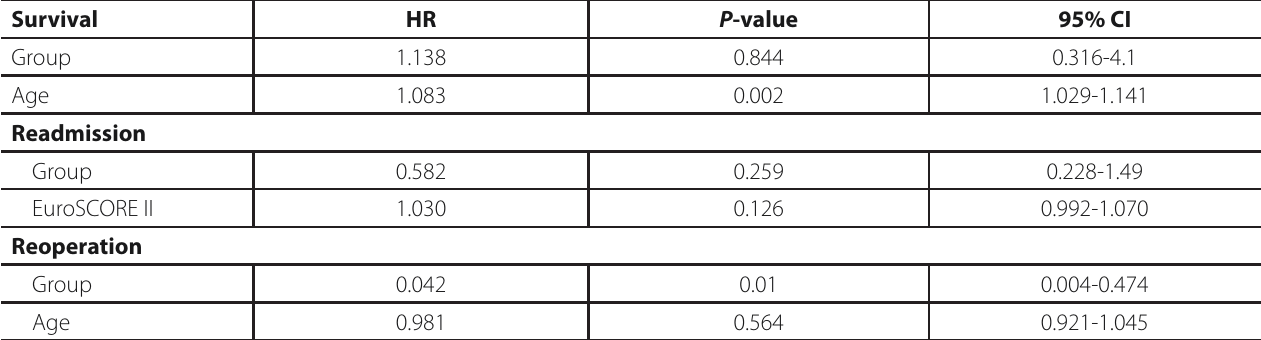
Table 6. Multivariable Cox regression for factors affecting survival, cardiac readmission, and reoperation (proportional hazard assumption test P =0.948, 0.144 and